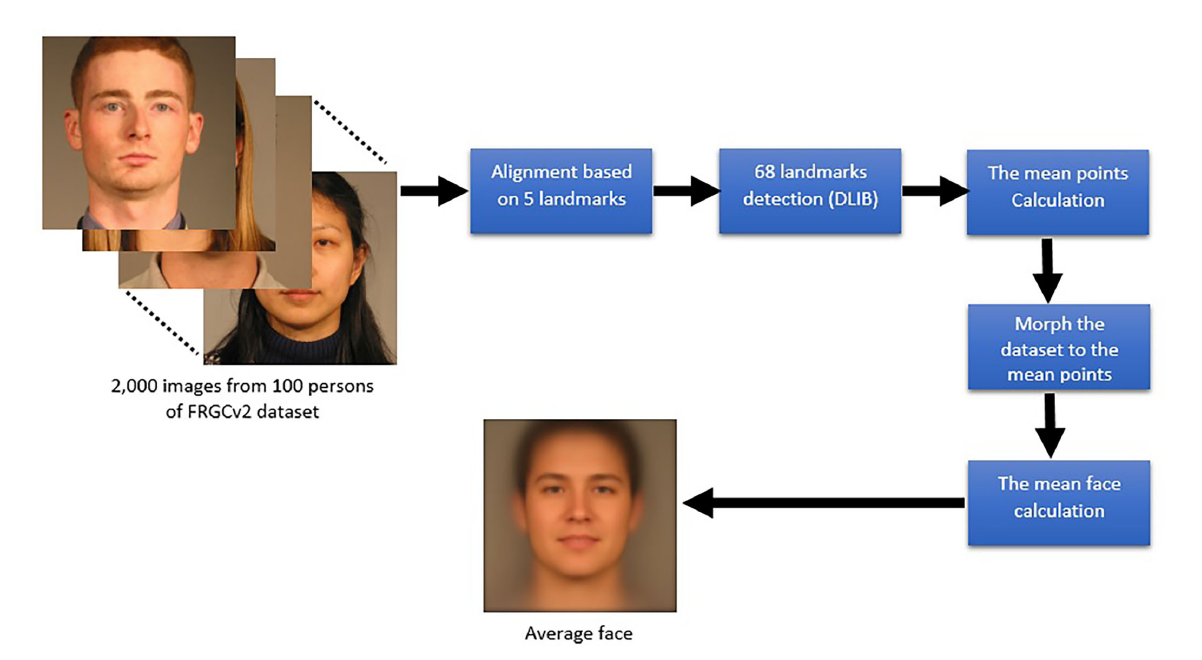
FIGURE1 The calculation of an average face. The process required all images were in the same landmarks.